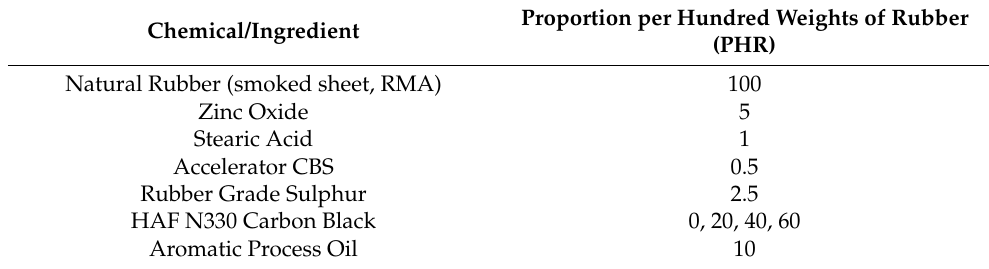
Table 1. Constituents of the filled and unfilled vulcanized NR.